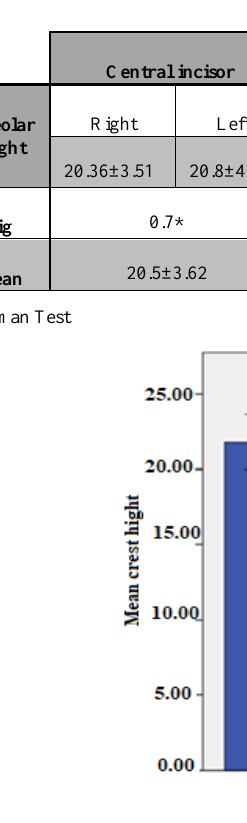
Fig. 3. Genderwise Distribution of alveolar Crest.